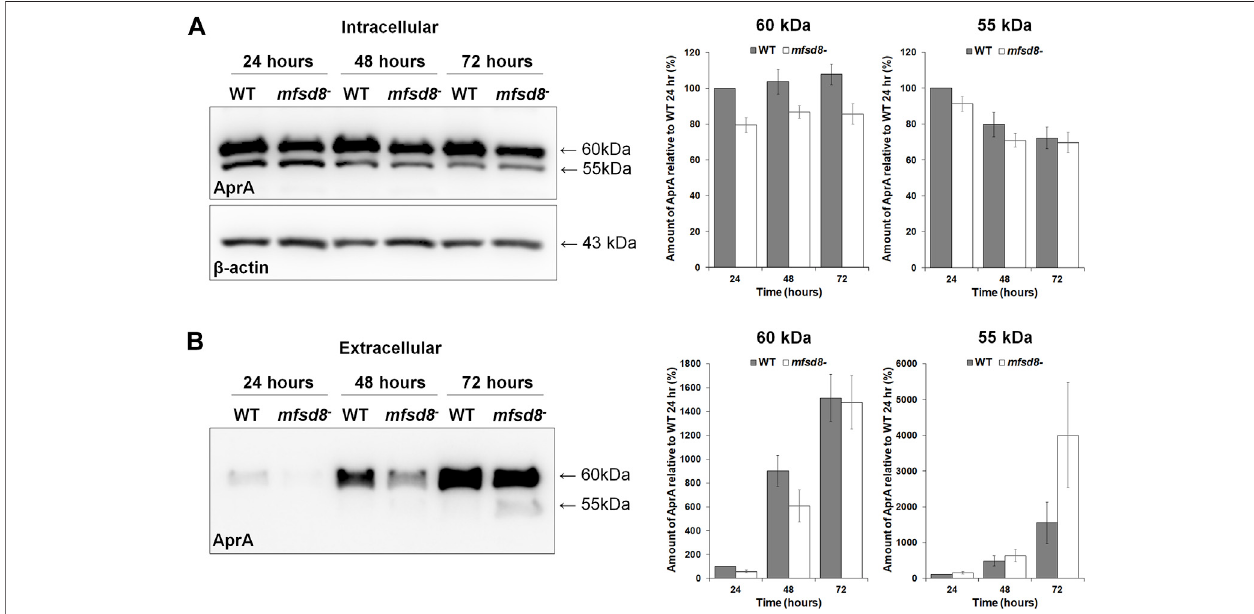
FIGURE 3 | Effect of mfsd8 -de fi ciency on the intracellular and extracellular levels of AprA during growth. WT and mfsd8 − cells were grown in HL5, harvested after 24, 48, and 72 h ofgrowth, and lysed.Conditioned media (CM) wasalso harvested at each time point. (A) Whole celllysates (15 µg) were separated by SDS-PAGE and analyzed by western blotting with anti-AprA and anti- β -actin (loading control). Molecular weight markers (in kDa) are shown to the right of each blot. Protein bands were quanti fi ed using Fiji/ImageJ. The amounts of AprA were normalized against the amounts of β -actin. Data presented as mean amount of AprA relative to WT 24 h (%) ± SEM ( n = 7). (B) Samples of CM were harvested at each time point and standardized against cell number. Equal volumes of CM (15 μ l) were separated by SDS- PAGE and analyzed by western blotting with anti-AprA. Molecular weight markers (in kDa) are shown to the right of each blot. Protein bands were quanti fi ed using Fiji/ ImageJ. Data presented as mean amount of AprA relative to WT 24 h (%) ± SEM ( n =